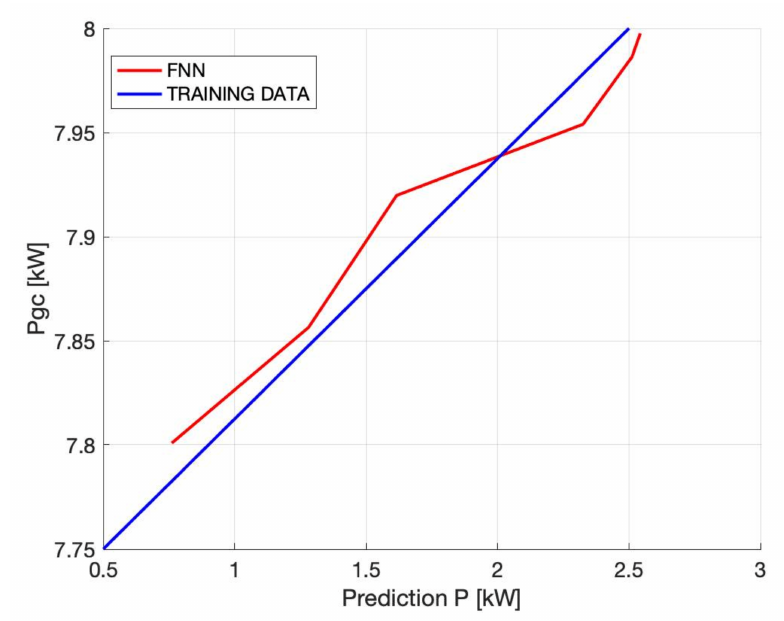
Figure 31. Compilation of the training data with the machine response, scenario 1.